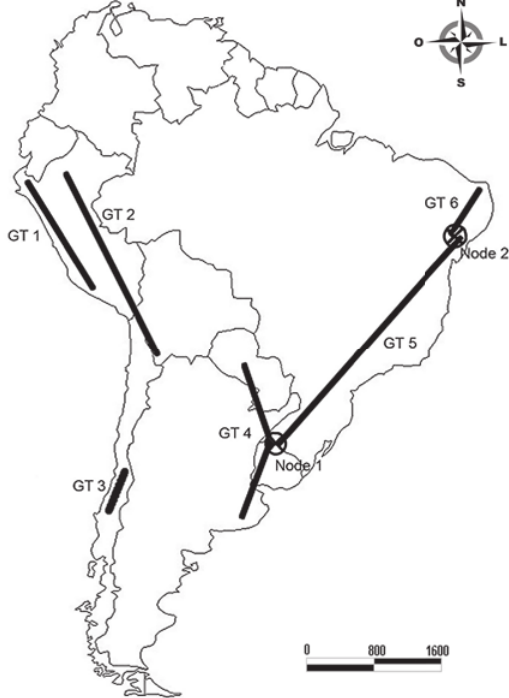
Fig. 22 - Generalized tracks and